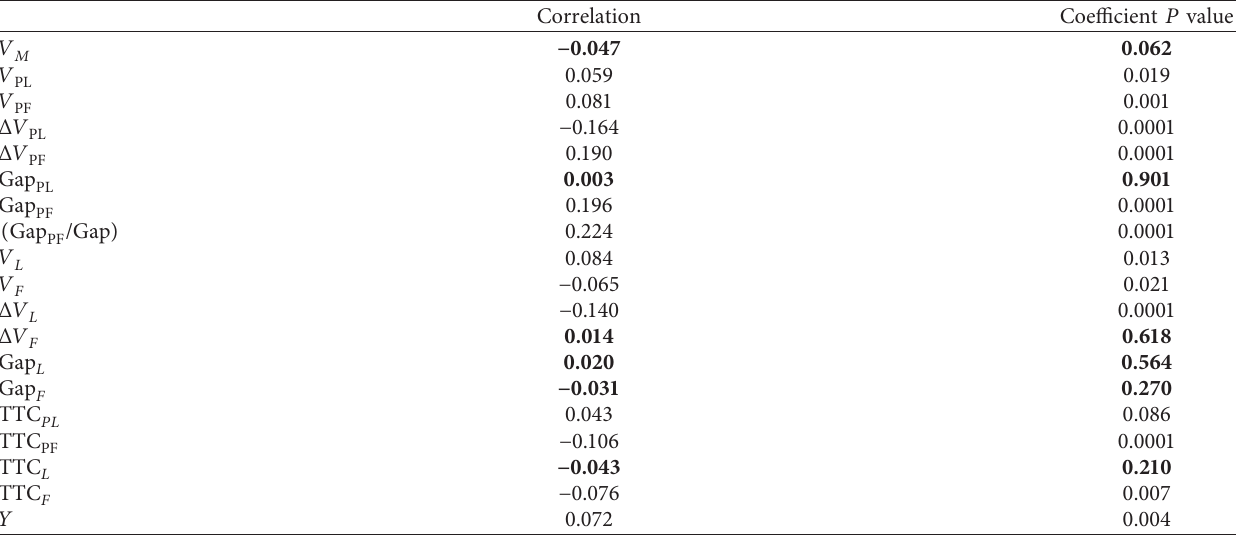
Table 4: Correlation coefficients between dependent variables and independent